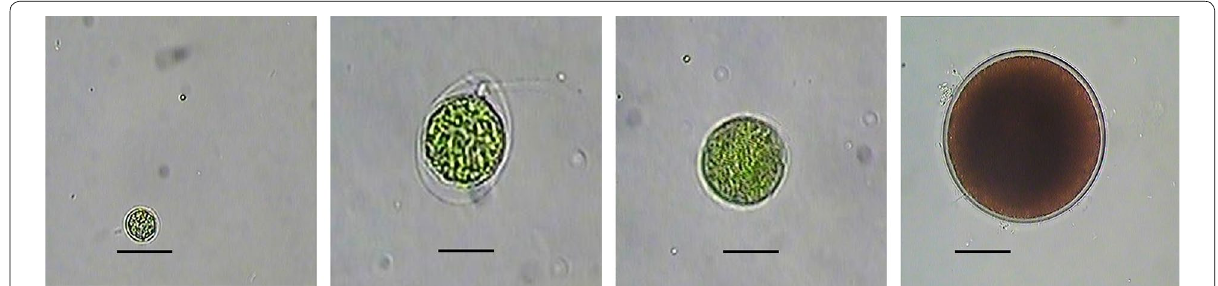
Fig. 1 Four cell types of H . pluvialis . From left to right represents spores, motile cells, non-motile cells and akinetes. Bar